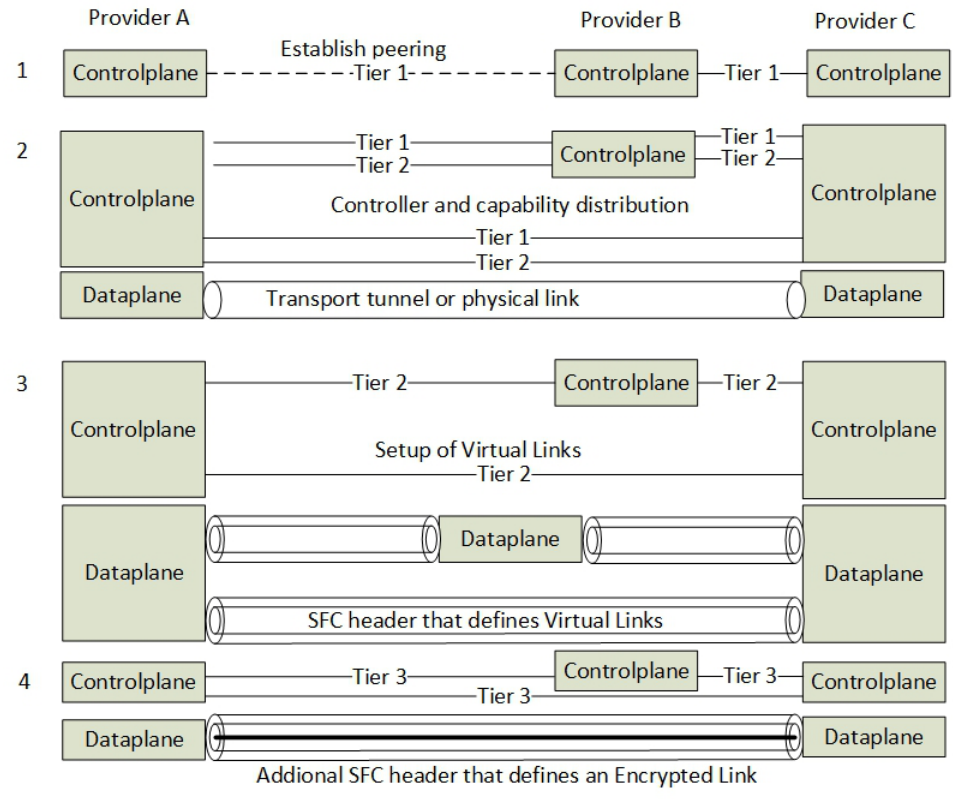
Figure 24. A visualization of the automated